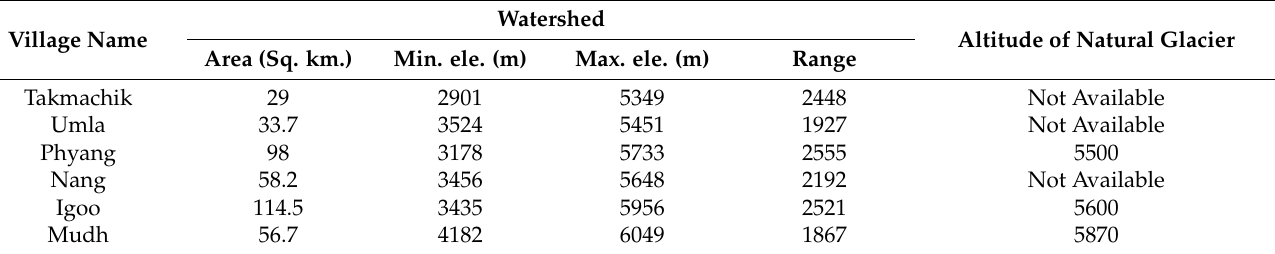
Table 2. Watershed and Glaciers in study villages.